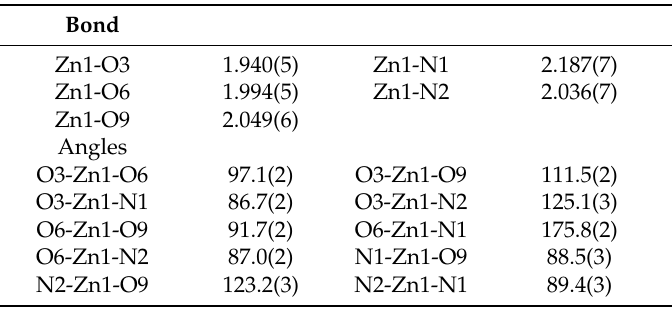
Figure 2. ( a ) Molecular structure and atom numberings of complex 1 with 30% probability displacement ellipsoids (hydrogen atoms are omitted for clarity). ( b ) Coordination polyhedron for Zn(II) ion of complex 1 . Table 2. Selected bond lengths (Å) and angles ( ◦ ) for complex 1 . Table 3. Hydrogen bonding and C-H··· π stacking interactions (Å, ° ) for complex 1 .